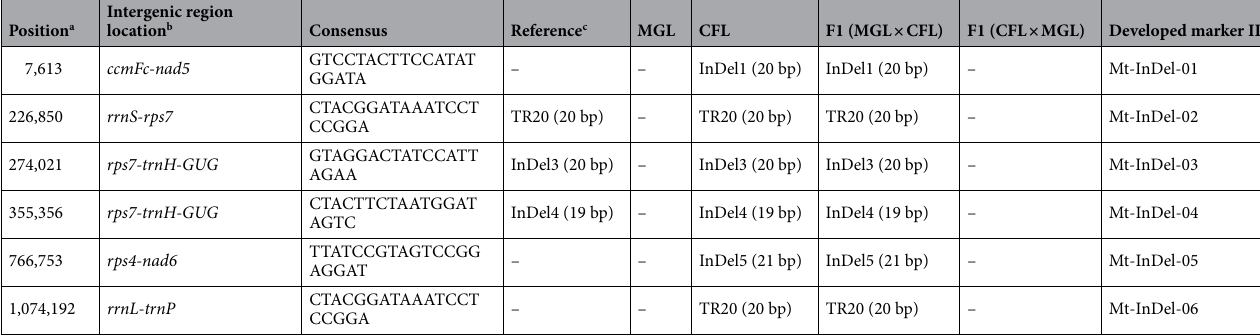
Table 2. InDel sites and sequences with length difference of more than 20 bp in mt sequences between two parental lines. a,b,c Based on mt genome sequence (NC_016005.1, 1,555,935 bp) previously reported in cucumber cultivar Calypso 32 . “–”, is representing non-detected indels or tandem